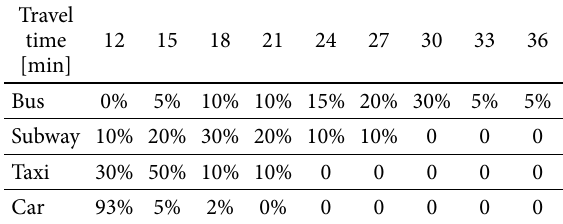
Table 4. Traveller’s estimation on different modes’ travel time changing